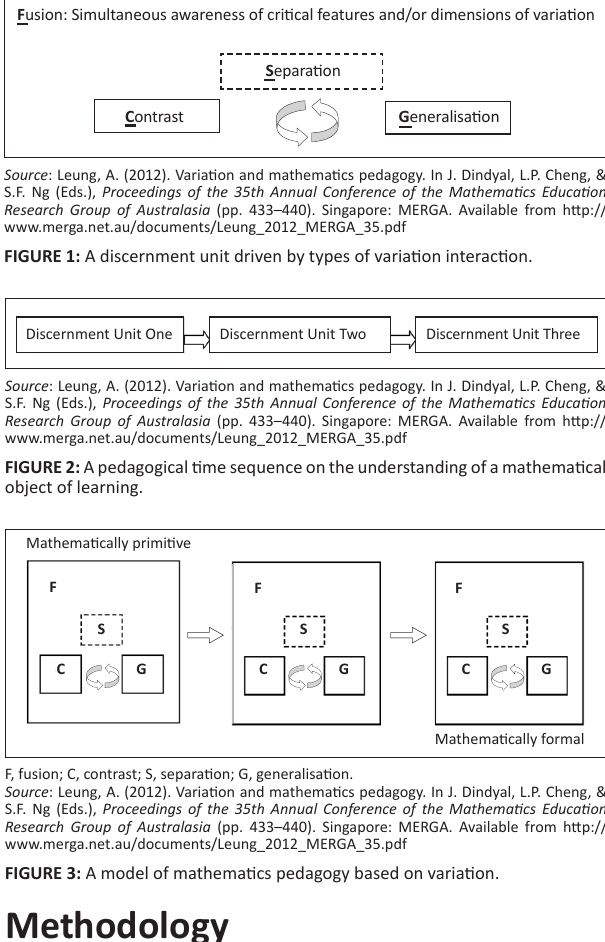
FIGURE 3: A model of mathematics pedagogy based on variation.